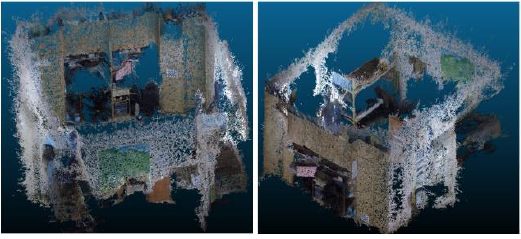
Figure 8. A spatial model of the mapped area The obtained dense point cloud had a resolution of 0.05 m, and consist of more than 0.5 million points.